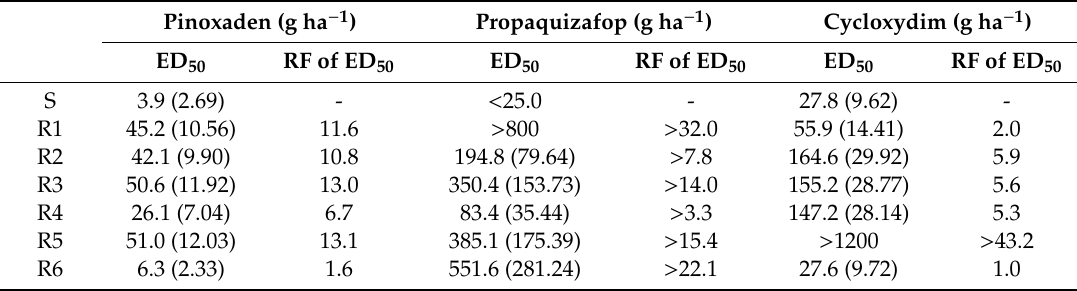
Figure 3. Dose-response curves for survival ( A ) and shoot dry weight ( B ) of susceptible (S) and test populations (R1 to R6) of A. fatua treated with a range of dose rates covering from 0.25 × to 8 × recommended field rate of propaquizafop. Arrows indicate the recommended field rate of 100 g propaquizafop ha − 1 for A. fatua control. Note: most resistant populations recorded high survival at the highest dose used, while the control of two susceptible populations at the lowest dose was virtually complete, therefore, a model ( A ) could not be fitted with the S1 and S2. Table 2. Survival ED 50 (standard errors in parentheses) of susceptible (S) (mean values of S1 and S2) and test populations (R1 to R6) of A. fatua treated with a range of ± recommended field rate of rate of cycloxydim 150 g ha − 1 . Resistance factor (RF) was calculated as the ratio of ED 50 values of test and susceptible